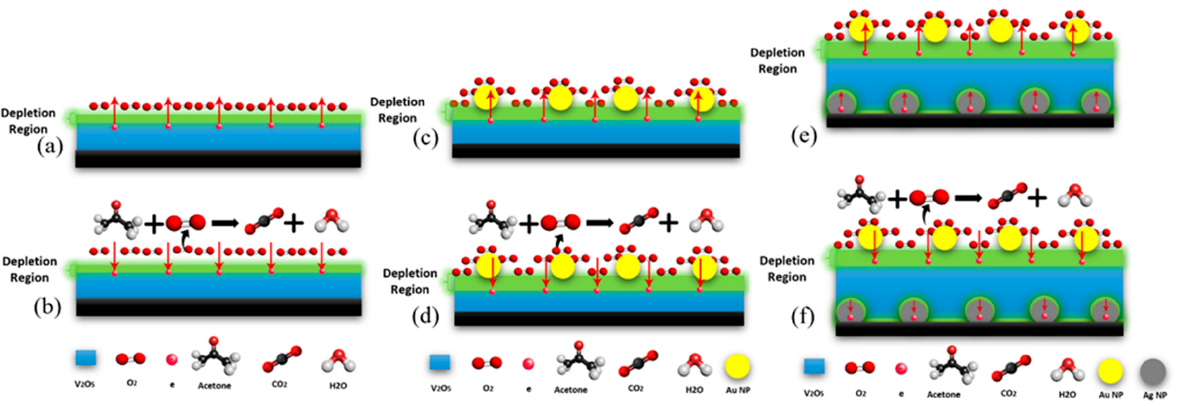
Figure 10. Mechanism illustration for acetone gas sensing in the presence of V 2 O 5 ( a , b ), Ag/V 2 O 5 thin film ( c , d ), and Ag NPs/V 2 O 5 thin film/Au NPs ( e , f ).